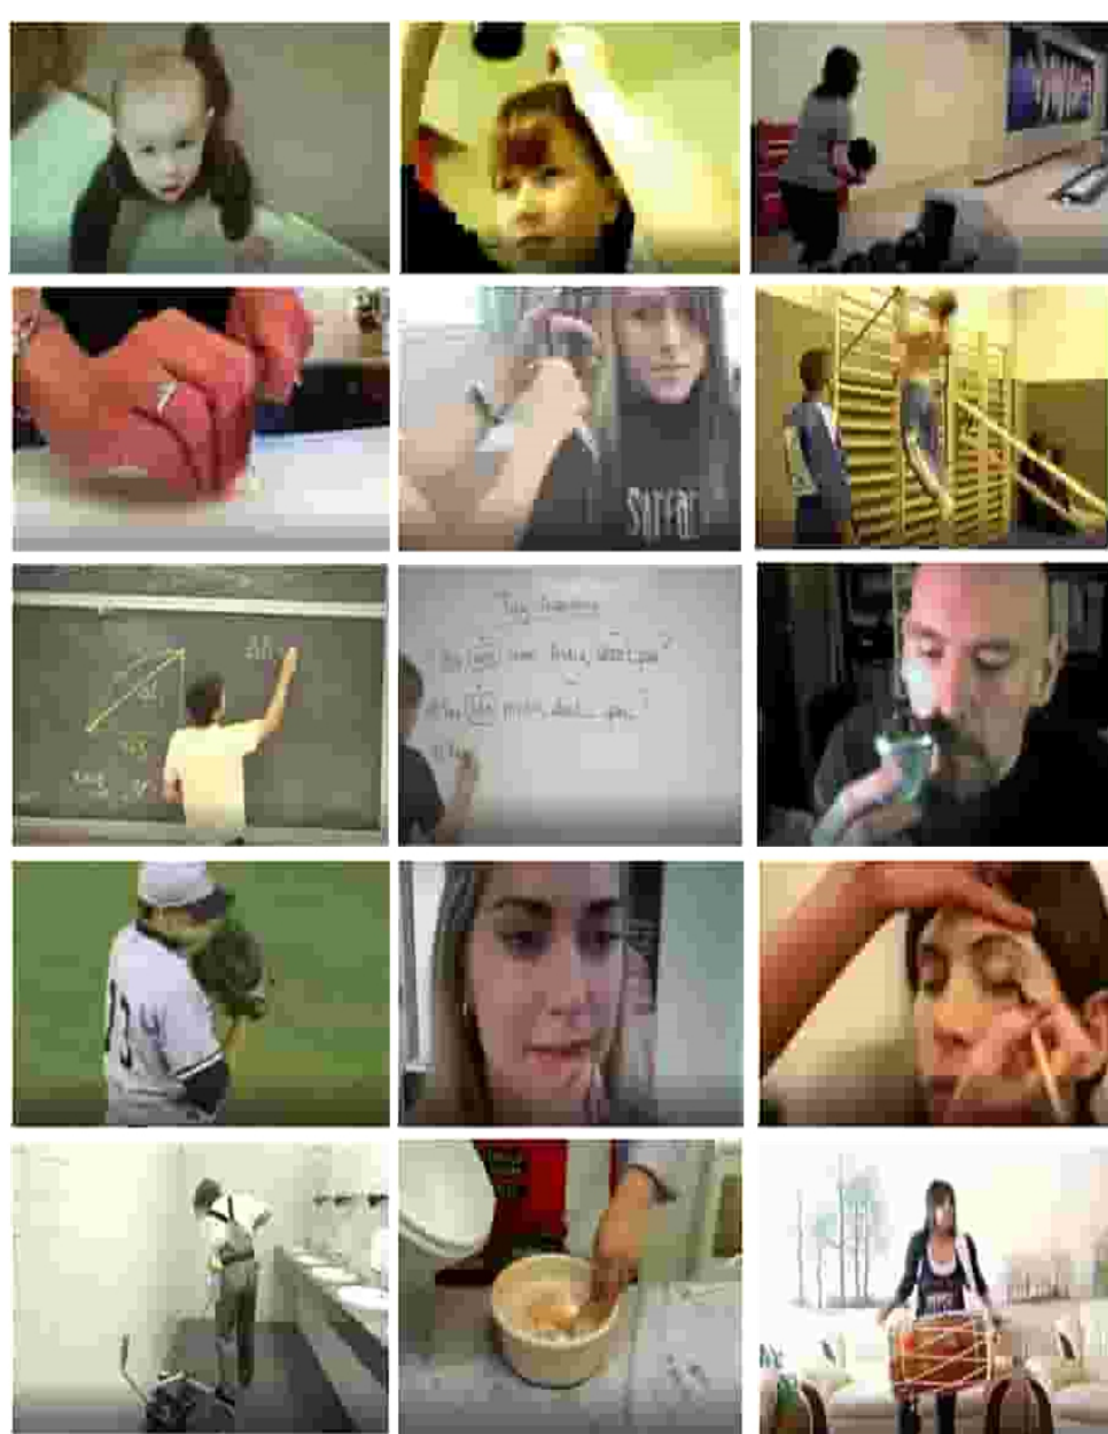
Figure 8. A random batch of raw samples from Kinetics-700, UCF101 and HMDB51 datasets trained on 48